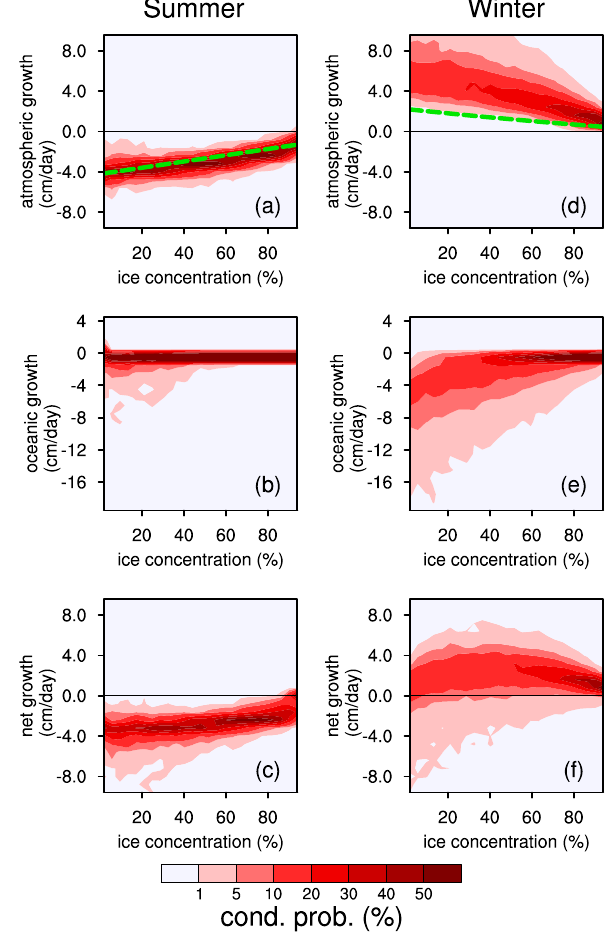
Fig. 10. Conditional probability densities with which heat fluxes contributing to sea-ice growth occur for a given sea-ice concentra- tion. The occurrence probabilities were diagnosed from a long run of ECHAM5/MPI-OM for representative summer (a–c) and win- ter (d–f) conditions. Heat fluxes are given as equivalent ice growth rates (1cmday − 1 = 35Wm − 2 ). Heat fluxes shown in (a and d ) are between the ice and the atmosphere, and in ( b and e ) between the ice and the ocean. ( c and f ) show the net growth rates of the sea ice, which are equivalent to the sum of atmospheric and oceanic heat flux into the ice. The dashed green line is the dependence found in the simple radiative ice-energy balance